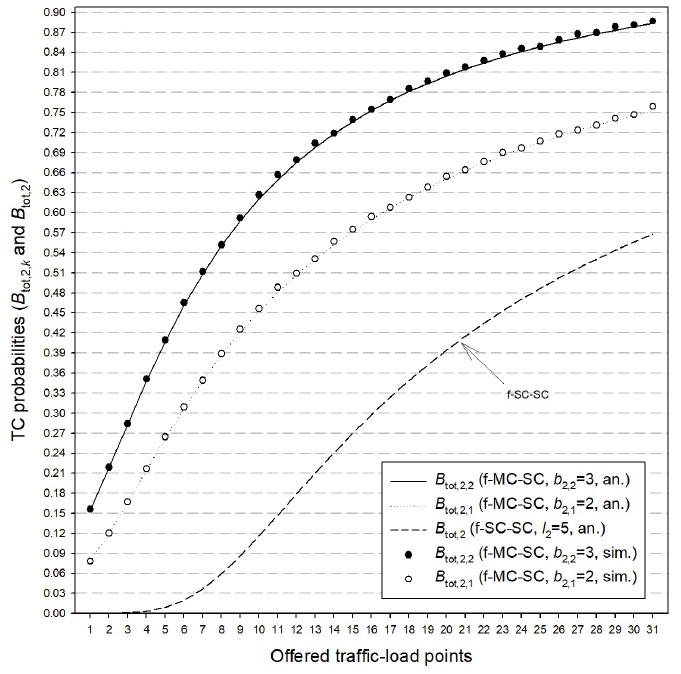
Figure 8. Total TC probabilities (2nd RRH—all service